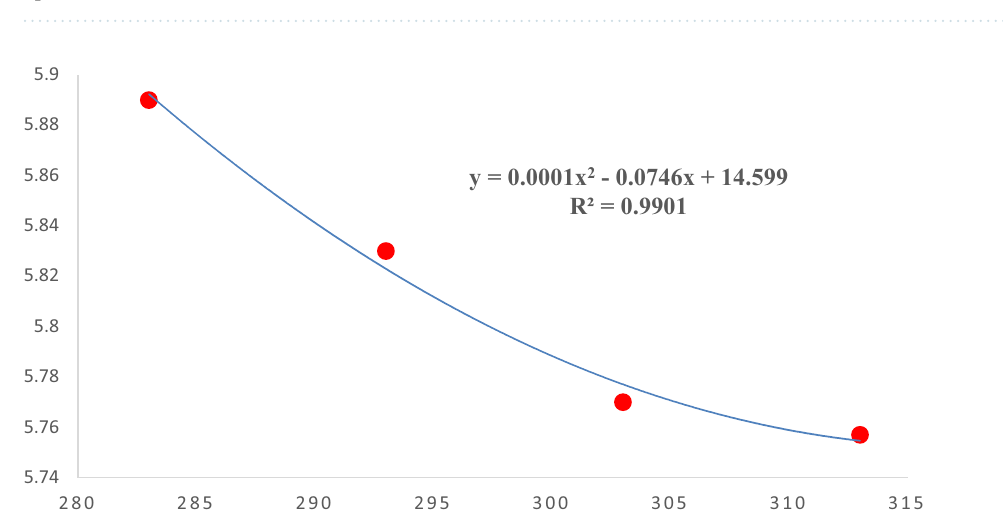
Figure 6. Linear ( a – d ) curves of the kinetic models of fluoride adsorption on the bivalve shell under the optimized condition.